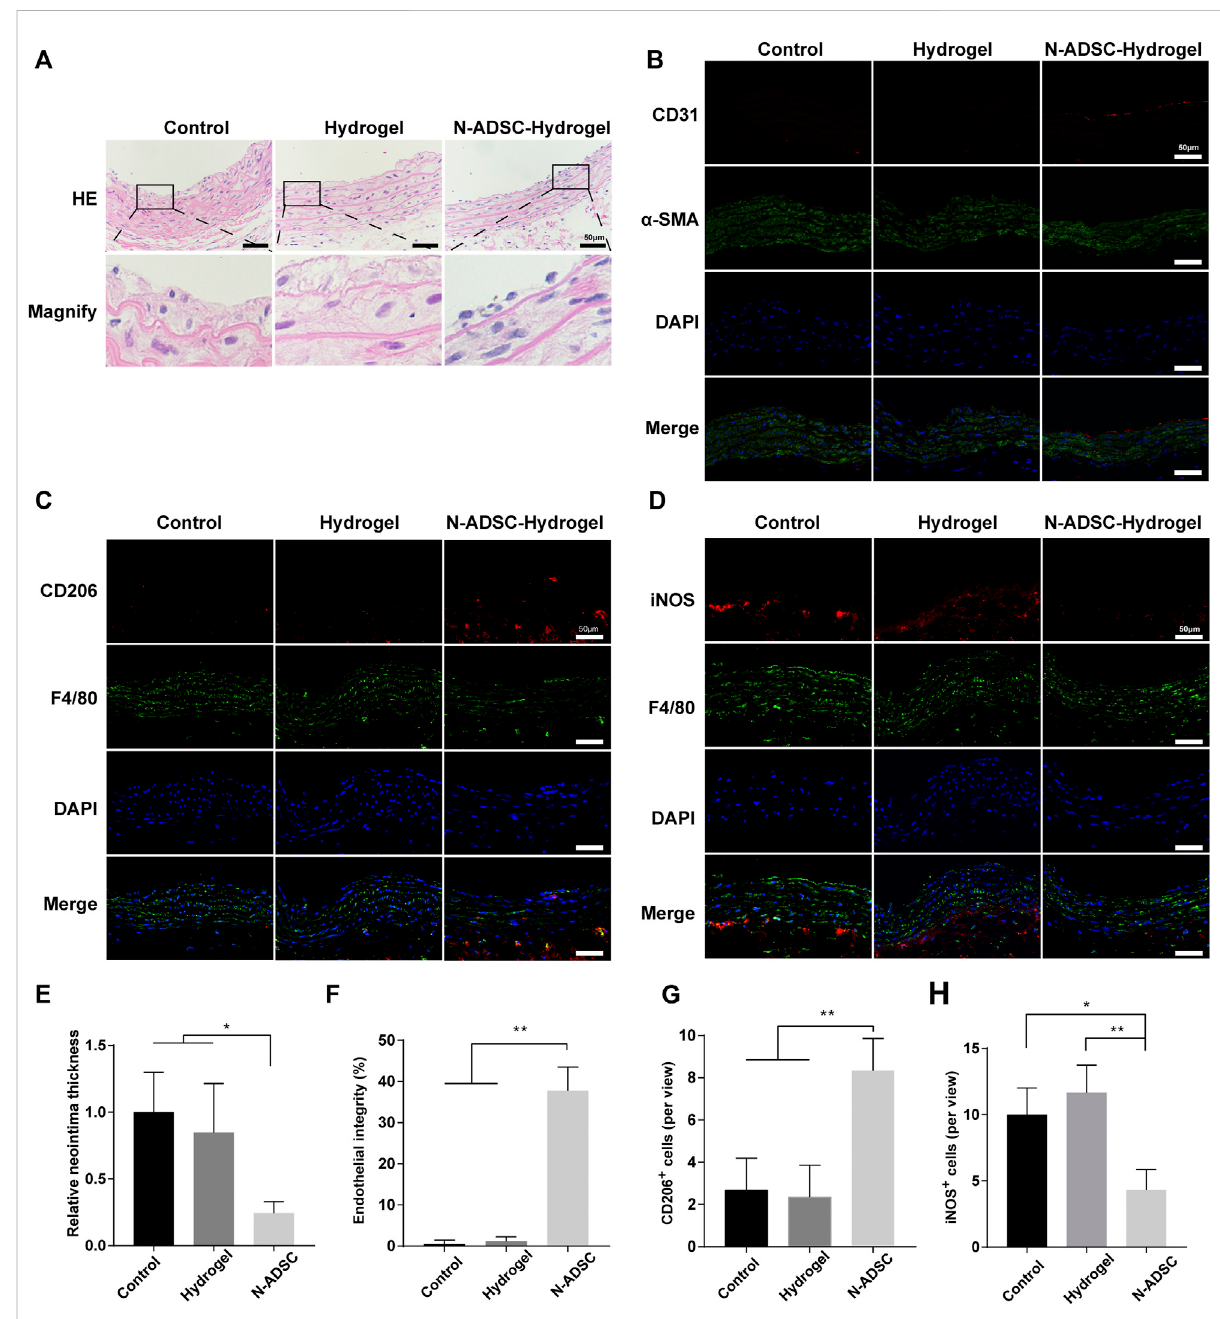
FIGURE 6 The effect of N-ADSC-loaded adhesive DN hydrogels on macrophage polarization and intimal hyperplasia in vivo . (A,E) HE staining and statistical analysis of the thickness of the carotid neointima. (B,F) Immuno fl uorescence staining of CD31 (red) and α -SMA (green) depicting endothelial integrity. (C, G) Immuno fl uorescence staining of CD206 (red) and F4/80 (green) and analysis of CD206+ cells. (D,H) Immuno fl uorescence staining of iNOS (red) and F4/80 (green) and analysis of iNOS + cells. * p < 0.05. ** p < 0.01. Scale bar = 50 μ m. N-ADSCs, Netrin-1-modi fi ed adipose-derived stem